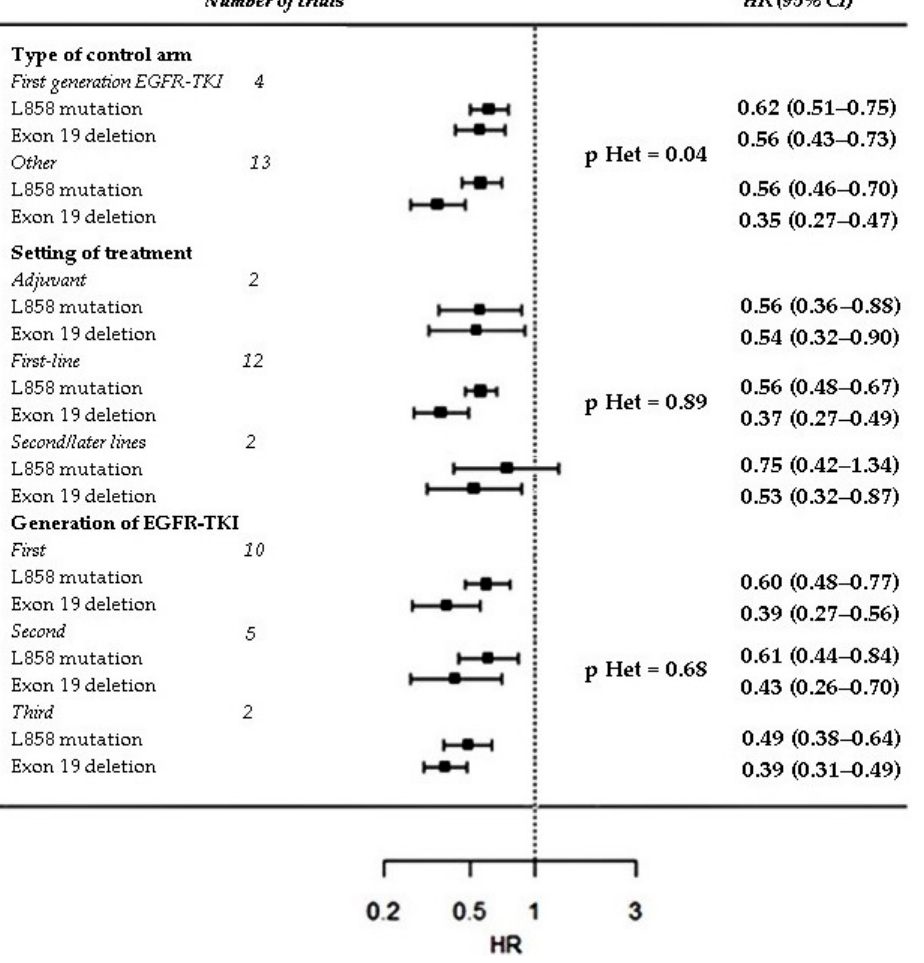
Figure 7. Subgroup analysis of PFS interaction with type of EGFR mutation. Trials are grouped according to type of control arm (first-generation EGFR-TKI vs. other), setting / line of treatment (adjuvant vs. first line vs. other) and generation of the EGFR-TKI tested in the experimental arm (first vs. second vs. third). P value for heterogeneity (p Het) among pooled ratios of the PFS-HRs in patients with exon 21 L858R mutation vs. exon 19 deletion estimated in trial subgroups is provided.